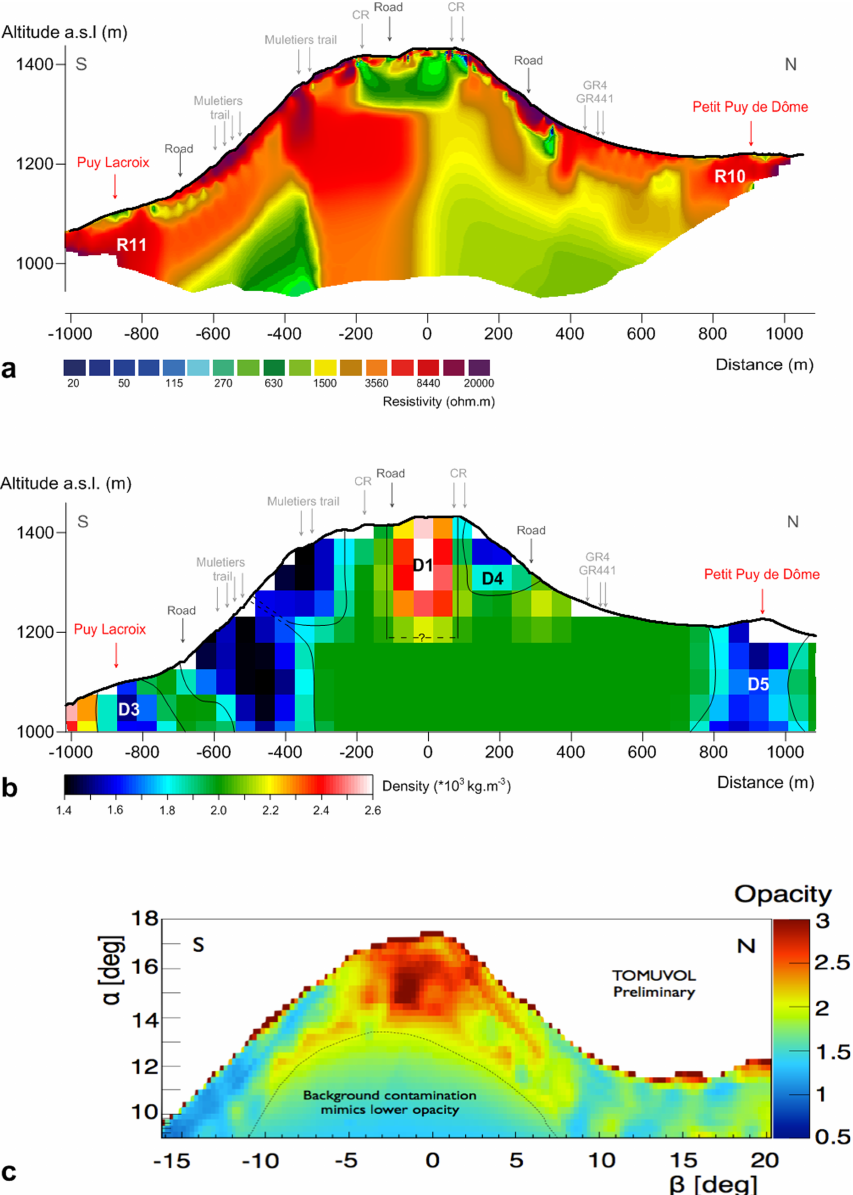
Fig. 5. Comparison of geophysical models along north–south direction: (a) 2-D resistivity model, (b) 3-D density model from gravimetry and (c) opacity model from muonic tomography (Cˆarloganu et al.,